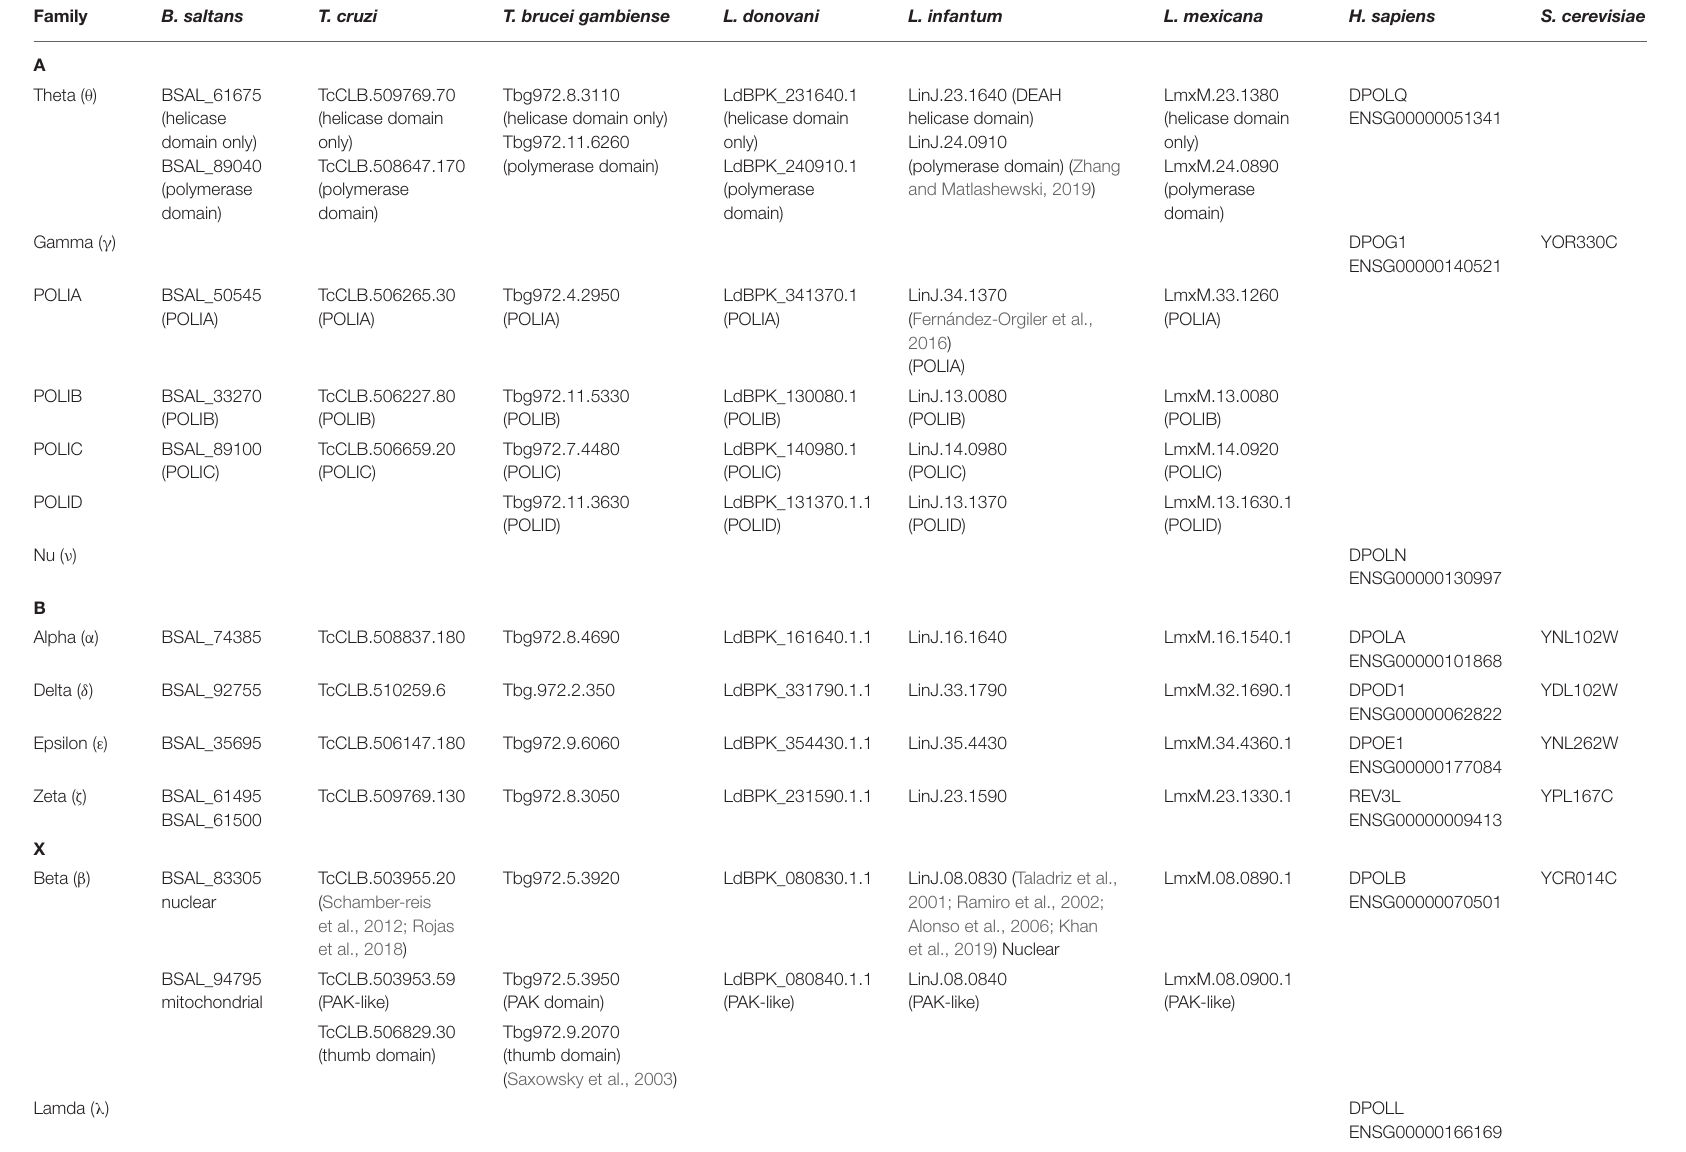
TABLE 1 | DNA polymerases detected in selected eukaryotic species.